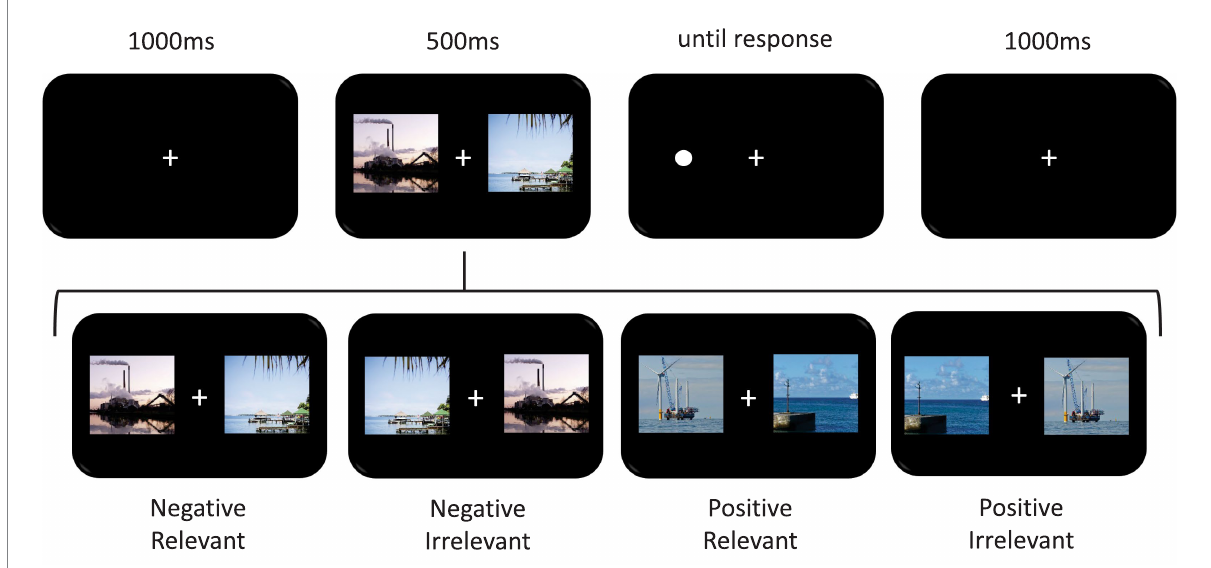
FIGURE 1 Trial structure of the dot-probe task of attentional bias. First, each trial started with a 1,000 ms white fixation cue (+) in the center of a black background. Second, two images were simultaneously presented to the left and right side of the fixation cue for 500 ms. All trials contained a climate relevant and a climate irrelevant image pair. These images each extended 10 ° × 12 ° of the visual angle and were separated by 14.5 ° of the visual angle. Third, a target dot appeared immediately after the images were removed and remained on the screen until a response was recorded. Fourth and finally, a 1,000 ms intertrial interval separated trials. Participants were seated 59 cm from the screen and instructed to focus on the central fixation cue throughout each trial while using their peripheral vision to locate the target dot as quickly as possible. An E-Prime serial response box was used to indicate left and right sided targets by (respectively) pressing the “1” button with their right index finger and the “2” button with their right middle finger. Faster reaction times to targets occurring at locations preceded by a climate change relevant image indicates attentional bias for the climate change relevant image over the irrelevant